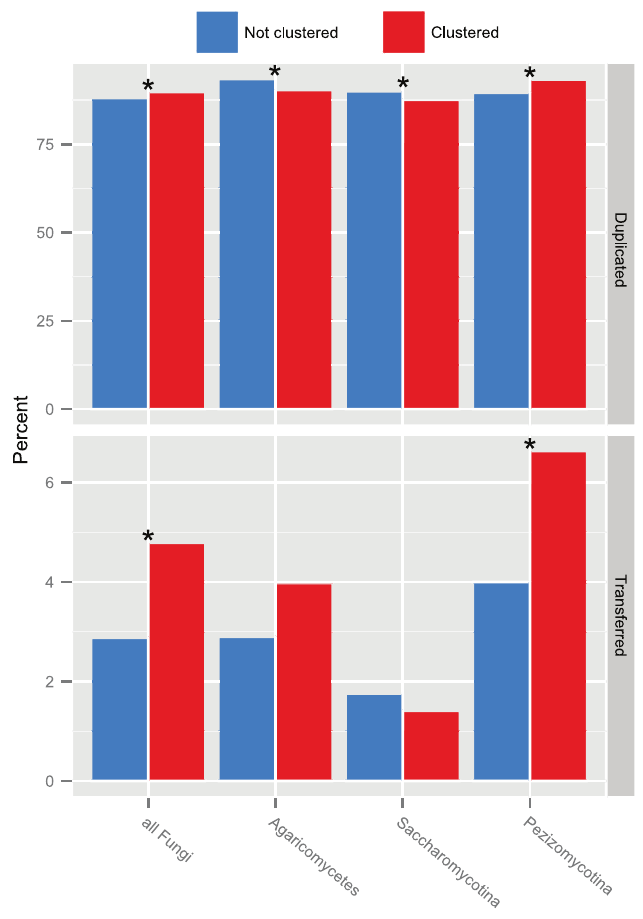
Figure 4. The association between gene innovation and gene clustering across three major fungal lineages. Percentage of non- clustered (blue bars) and clustered ECgenes (red bars) inferred to have undergone GD (top) and HGT (bottom). Asterisks (*) indicate statistically significant differences determined using a Benjamini & Hochberg adjusted P value # 0.05 in a two-tailed Fisher’s exact test (Table S6).